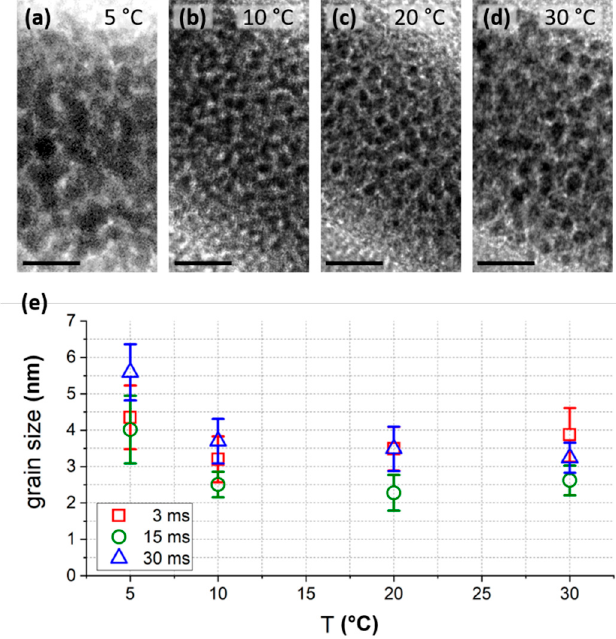
Figure 5. TEM microstructure analysis. In-scale comparison of TEM bright field images of tetrapod branches fabricated at ( a ) 5 ◦ C, ( b ) 10 ◦ C, ( c ) 20 ◦ C and ( d ) 30 ◦ C. Scale bars are 10 nm. ( e ) mean grain sizes (Feret-diameters) as a function of the T S and different dwell times, taken from tetra- pod structures.